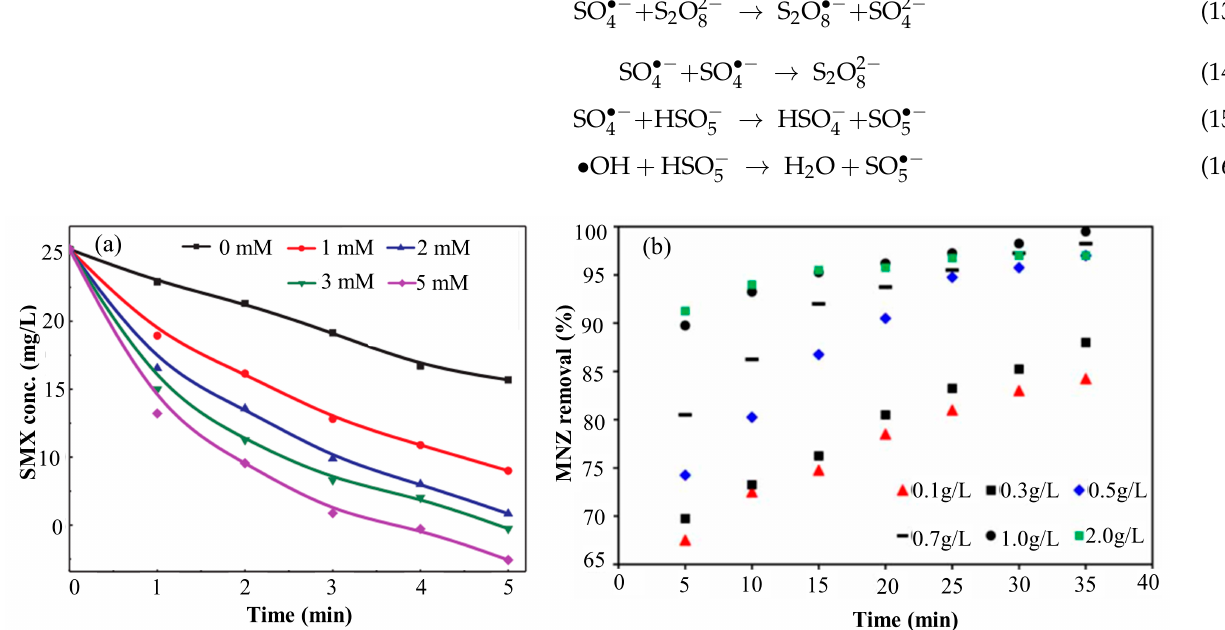
Figure 5. Effect of PDS concentration. ( a ) UV intensity 240 W, [SMX] = 0.1 mM, [PDS] = (0, 1, 2, 3, 5) mM [57]. Copyright (2020), with permission from Elsevier. ( b ) pH = 5, [MNZ] = 40 mg/L, [PDS] = (0.1, 0.3, 0.5, 0.7, 1.0, 2.0) g/L [62].